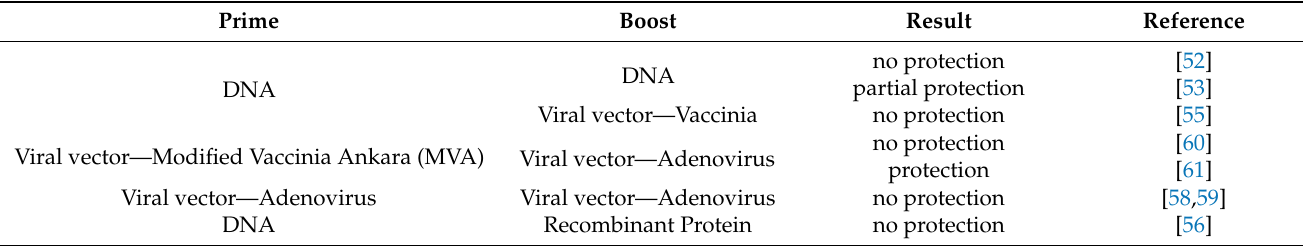
Table 1. Summary of Recombinant Subunit ASF Experimental Vaccines (Prime-Boost).